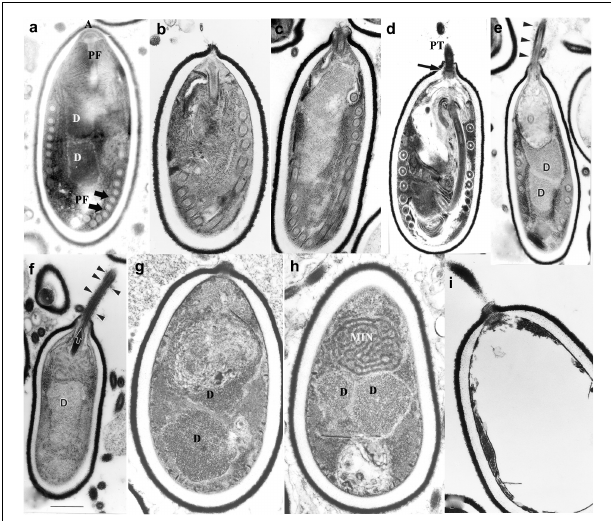
FIGURE 2 | Germination of microsporidian spore. Anncaliia algerae spores incubated in germination buffer and processed for TEM. The sequence of images illustrates the events that occur in the germination process. (a) Typical A. algerae spore; (b) spore coat bulging; (c) spore coat rupture and polaroplast expanded; (d) early eversion and translocation of polar tube (PT); (e) majority of PT extruded, nuclear and cytoplasmic structures still in spore; (f) no PT coils remain in spore but sporoplasm still present; (g) spore “membrane channels” visible immediately below endospore; (h) posterior vacuole, diplokaryon and MIN (sporoplasm) the last structures exiting the spore shell; (i) empty spore shell with PT still attached. Reprinted with the permission of the publisher (Cali and Takvorian,